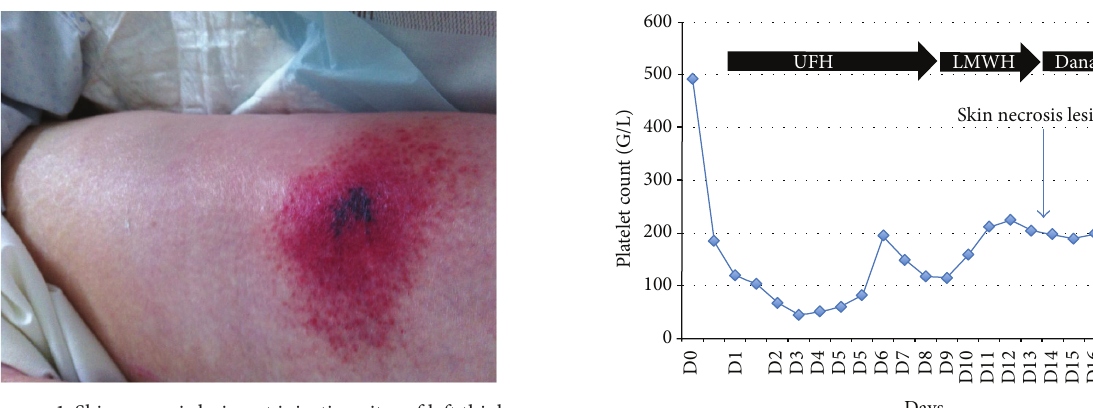
Figure 1: Skin necrosis lesion at injection sites of left thigh.